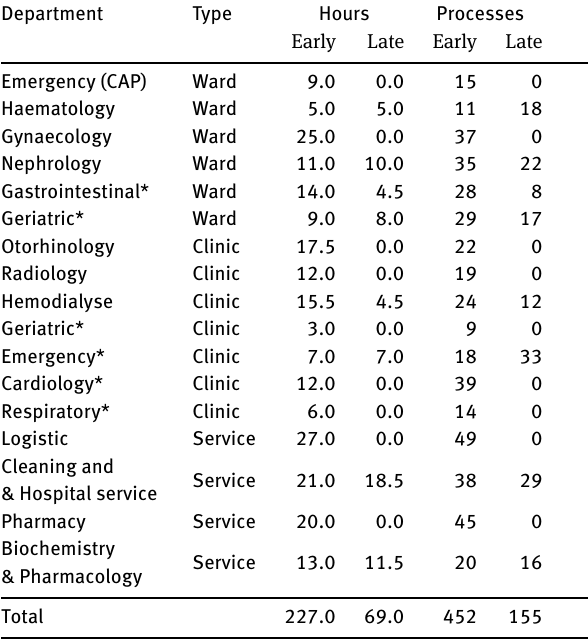
Table 1: Overview of the departments involved in the study grouped by type. * indicates departments located in Svendborg, Denmark; the remaining departments are located in Odense,